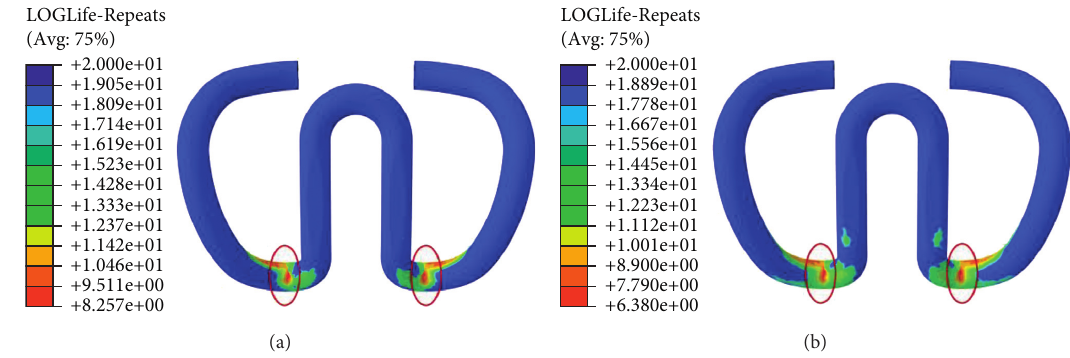
Figure 13: Fatigue crack initiation lives of the ω -shaped fastening clips: (a) case 1 and (b) case 2.